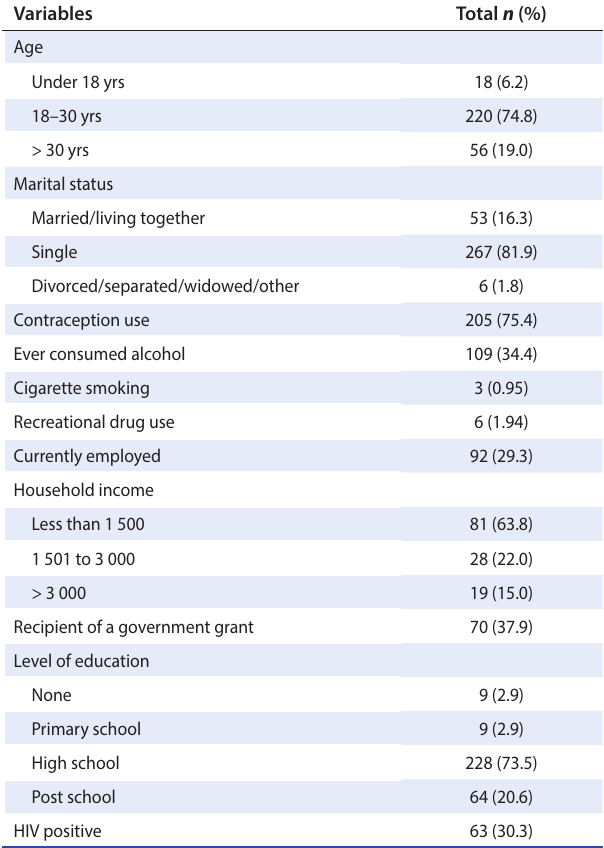
Table 1: Participant demographics ( n =